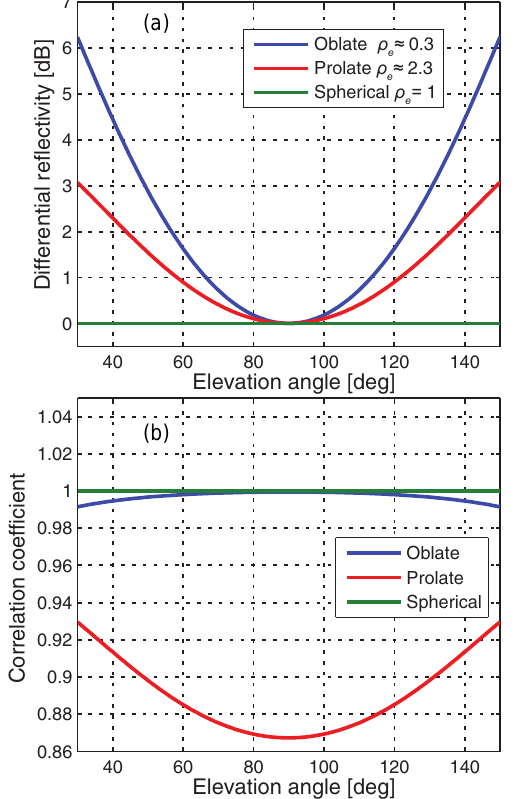
Figure 1. Elevation dependencies of modeled (a) Z DR and (b) ρ HV for strongly oblate (axis ratio (cid:28) 1), strongly prolate (axis ratio (cid:29) 1), and spherical (axis ratio of 1) solid ice particles (apparent ice density is 0.916gcm − 3 ). Polarizability ratios ρ e of each particle type are given in the legend. Particles are assumed to be oriented nearly horizontally with the degree of orientation ρ a of 0.99. The figure is based on look-up tables given in Myagkov et al. (2016).